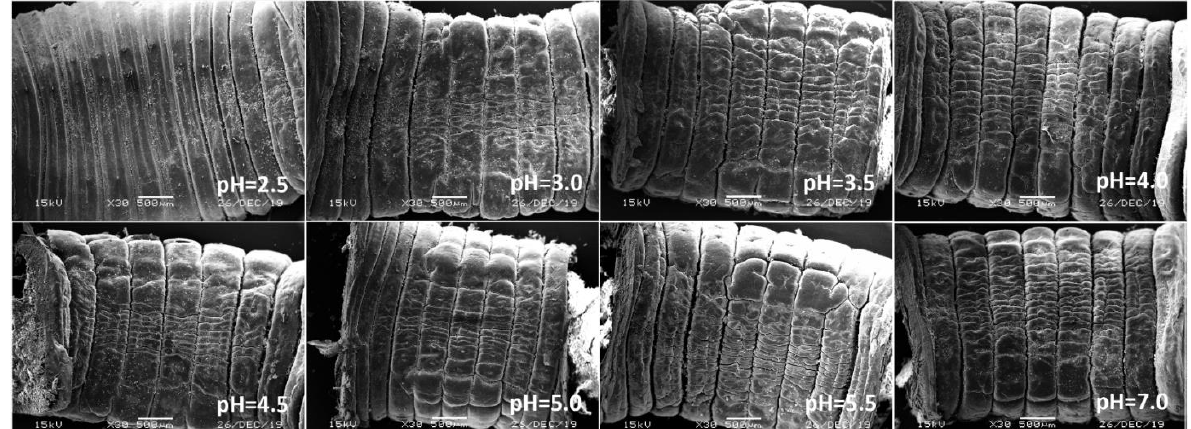
Figure 8. Ventral surface of the reproductive ring of adult Eisenia fetida on filter paper under acid rain with eight pH levels for 72 h ( n = 10). Treatments: pH 7.0: control, pH 2.0–5.5: acid rain with different pH levels.